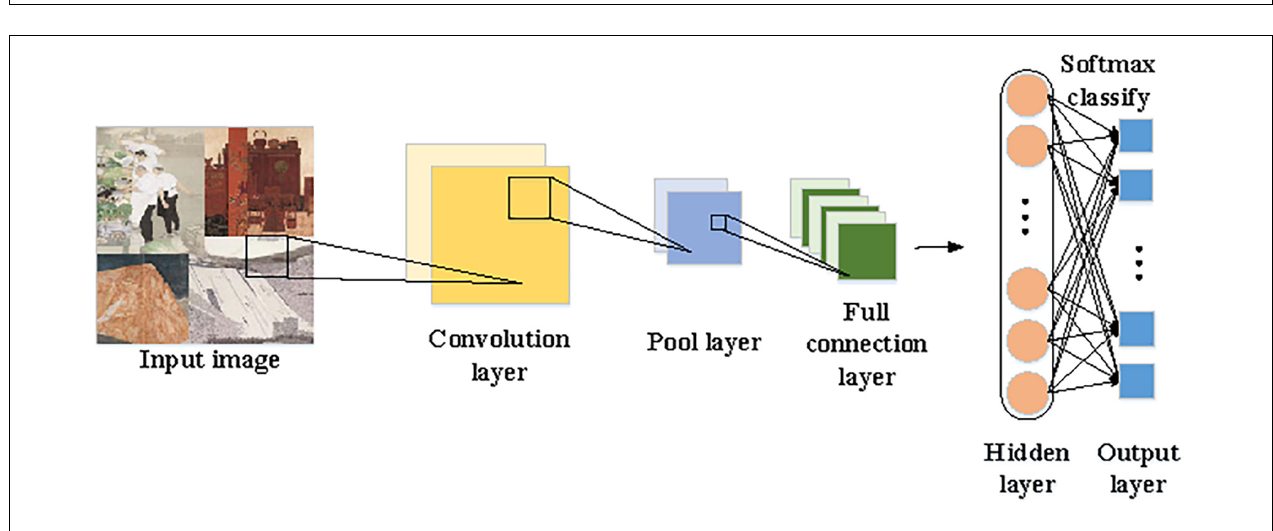
FIGURE 1 | A demonstration of recognizing human affects in Chinese paintings at the Thirteenth National Exhibition of Fines Arts in China.